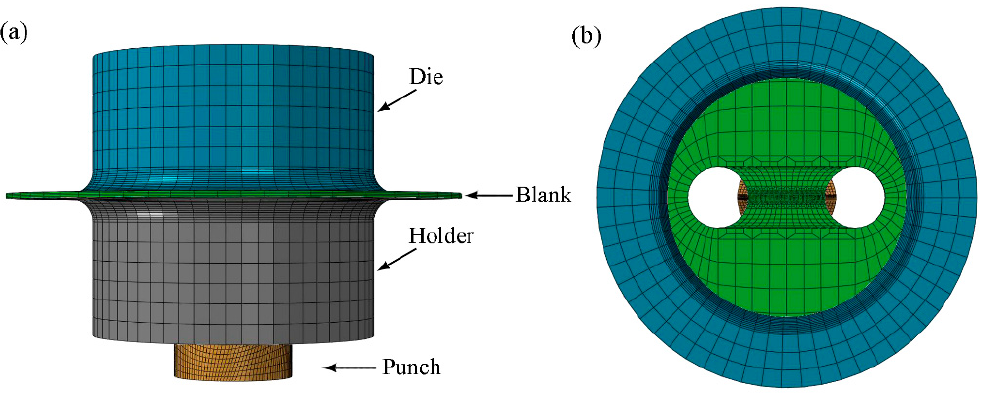
Figure 11. The FE model of the cyclic plane strain path loading: ( a ) front view; ( b ) vertical view. Table 8. Experimental procedure for cyclic plane strain